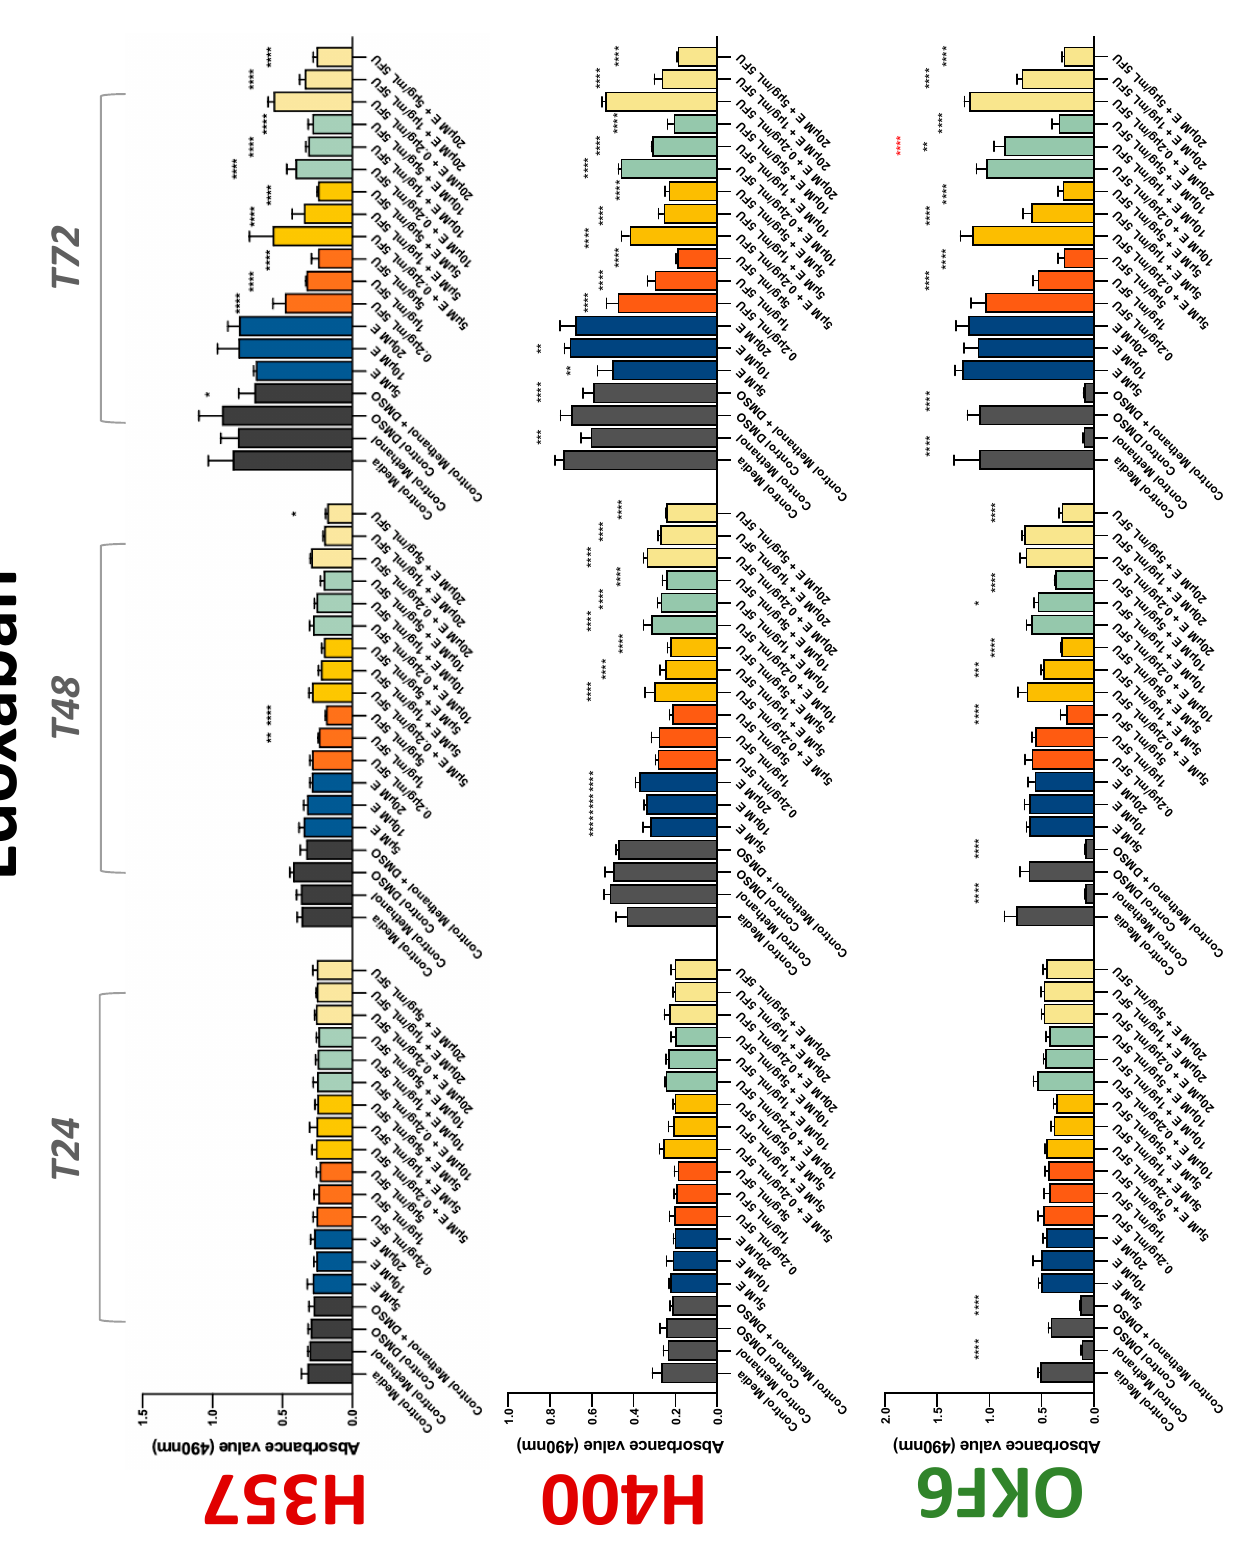
Figure 5. MTS assay . The effect of (5/10/20 μ M) edoxaban and (0.2/1/5/10 μ g/mL) 5-FU on H357, H400, and OKF6 cell proliferation. Data are represented as mean ± SD. Statistical significance is given as follows: * p < 0.05, ** p < 0.01, *** p < 0.005, **** p < 0.001; * (black) compared to control group; * (red) compared to respective 5-FU groups.